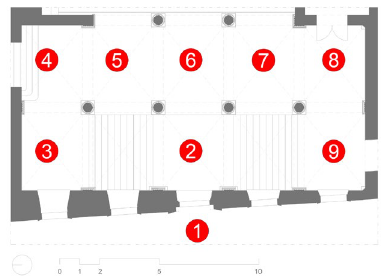
Figure 6 . Locations of the scanning